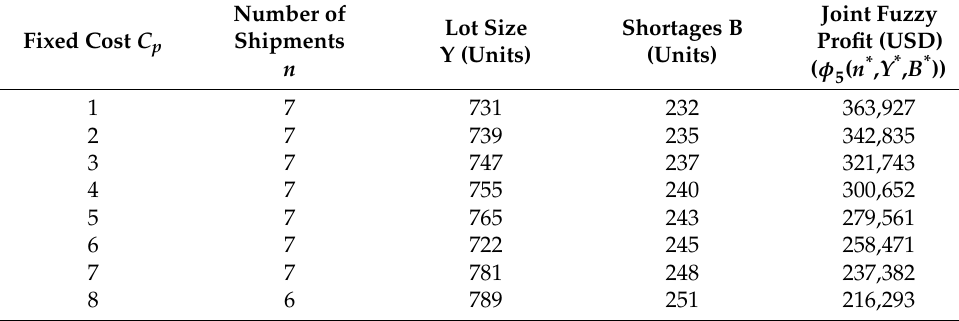
Table 14. Impact of the fixed cost on the joint fuzzy